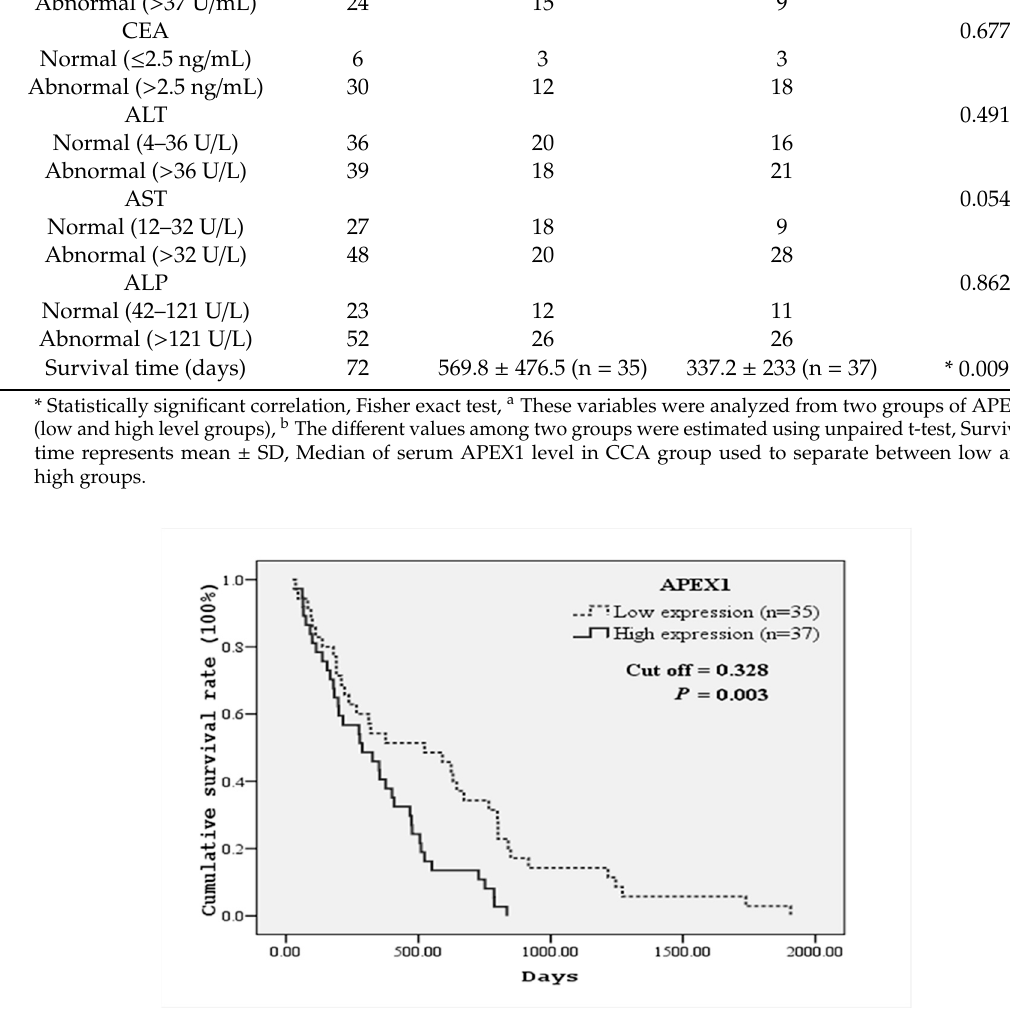
Figure 5. Kaplan–Meier survival curves of CCA patients based on serum APEX1 levels. CCA patients were divided into high and low serum APEX1 level groups using a median serum APEX1 value (0.328) of CCA patients as a cut-off. The curves show overall survival of CCA patients having high (solid line) and low (dashed line) serum APEX1 levels. A significant difference in the survival time was observed between high and low APEX1 level groups (log-rank test p -value=0.003).